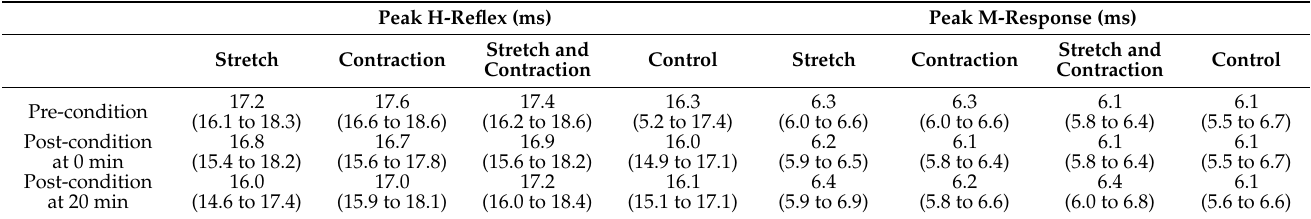
Table 2. Change in the latency time.